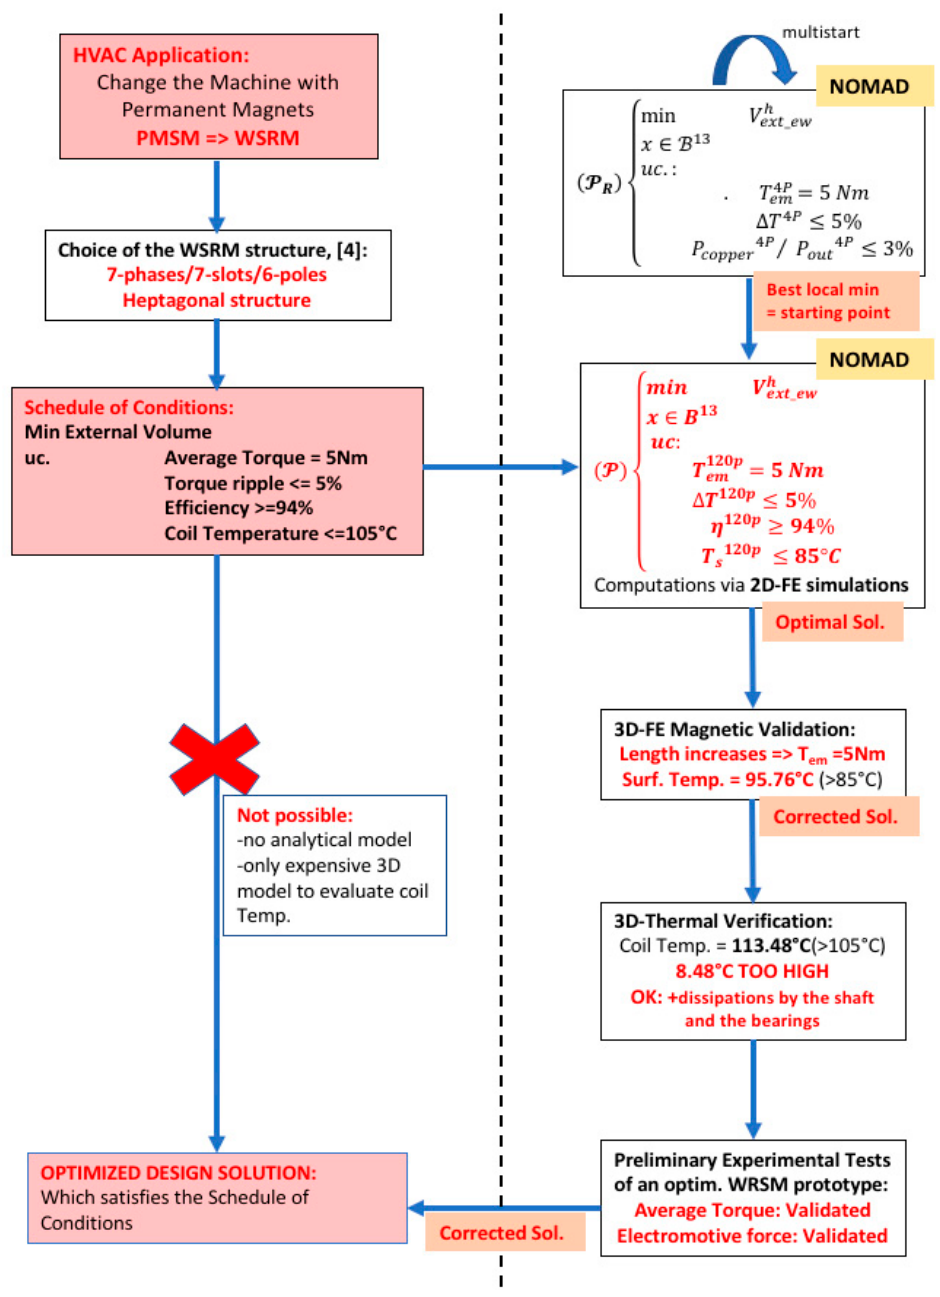
Figure A1. Methodology of a WSRM